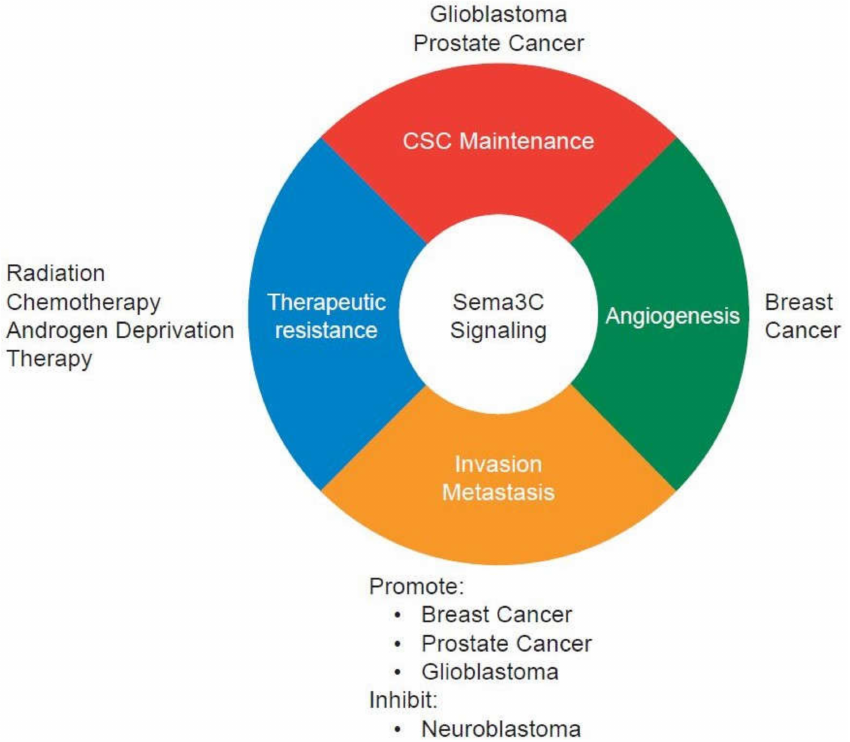
Figure 2. Context-dependent functions of Sema3C signaling in cancer progression. Sema3C signaling is implicated in cancer stem-like cell (CSC) maintenance, angiogenesis, invasion, metastasis, and therapeutic resistance. In breast cancer, furin-cleaved Sema3C is the active form and promotes tumor invasion, metastasis, and